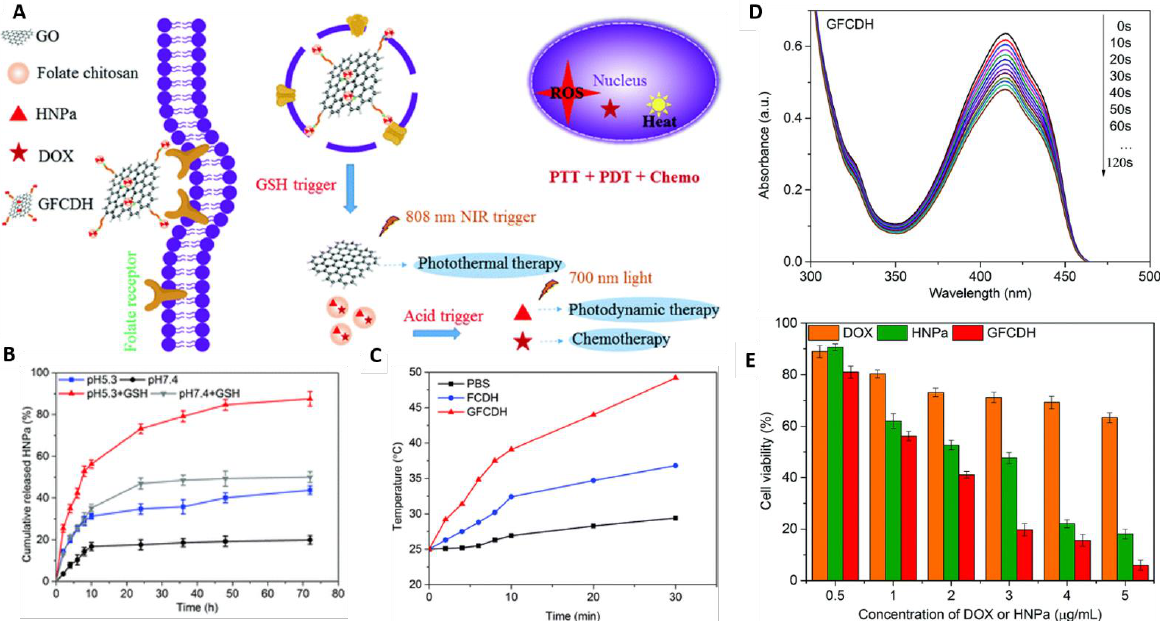
Figure 4. ( A ) Schematic diagram of multi-responsive nanocarrier for multi-modal therapy. This design uses DOX- and HNPa photosensitizer-loaded chitosan as a core (CDH). The chitosan is further conjugated with folate (FCDH) for targeting purposes. The FCDH core is conjugated to graphene oxide through amide bond and π – π conjugation between FCDH core and graphene oxide (GFCDH). ( B ) The pH and GSH responsive release of photosensitizer HNP. ( C ) Laser irradiation (808 nm and 0.8 Wcm − 1 ) triggered the increase in temperature. ( D ) UV-Vis spectra of nanocomposite loaded with diphenylisobenzofuran at different illumination times. A decrease in absorbance peak at 415 nm indicates singlet oxygen formation. ( E ) Cytotoxicity profile of DOX, HNPa, and nanocomposite at various concentrations. Reproduced from [164] with permission from the Centre National de la Recherche Scientifique (CNRS) and The Royal Society of